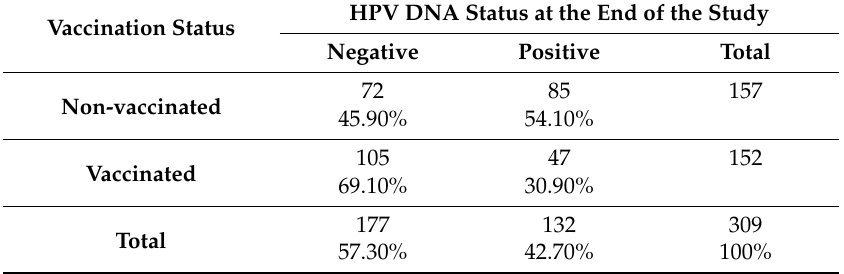
Table 4. HPV DNA status at the end of the study for the overall population grouped into vaccinated and non-vaccinated women. For each group, the top row of each cell represents the number of cases, while the lower row represents the percentage of cases being HPV DNA-negative or